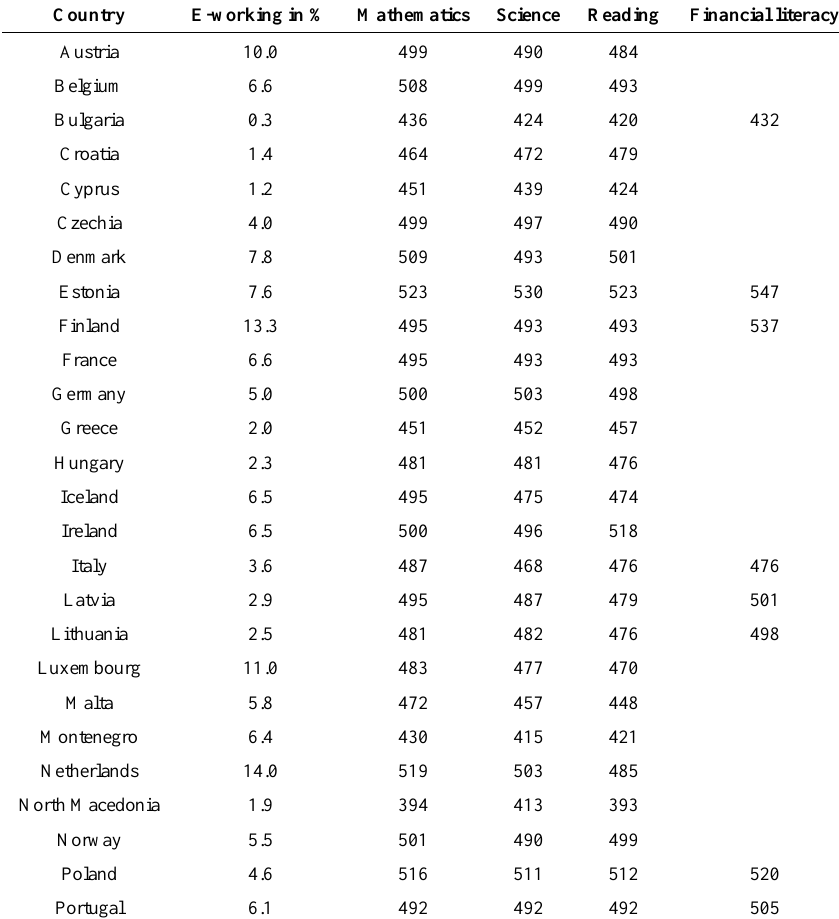
Table 1. E-working Ratio (2018) and PISA Results